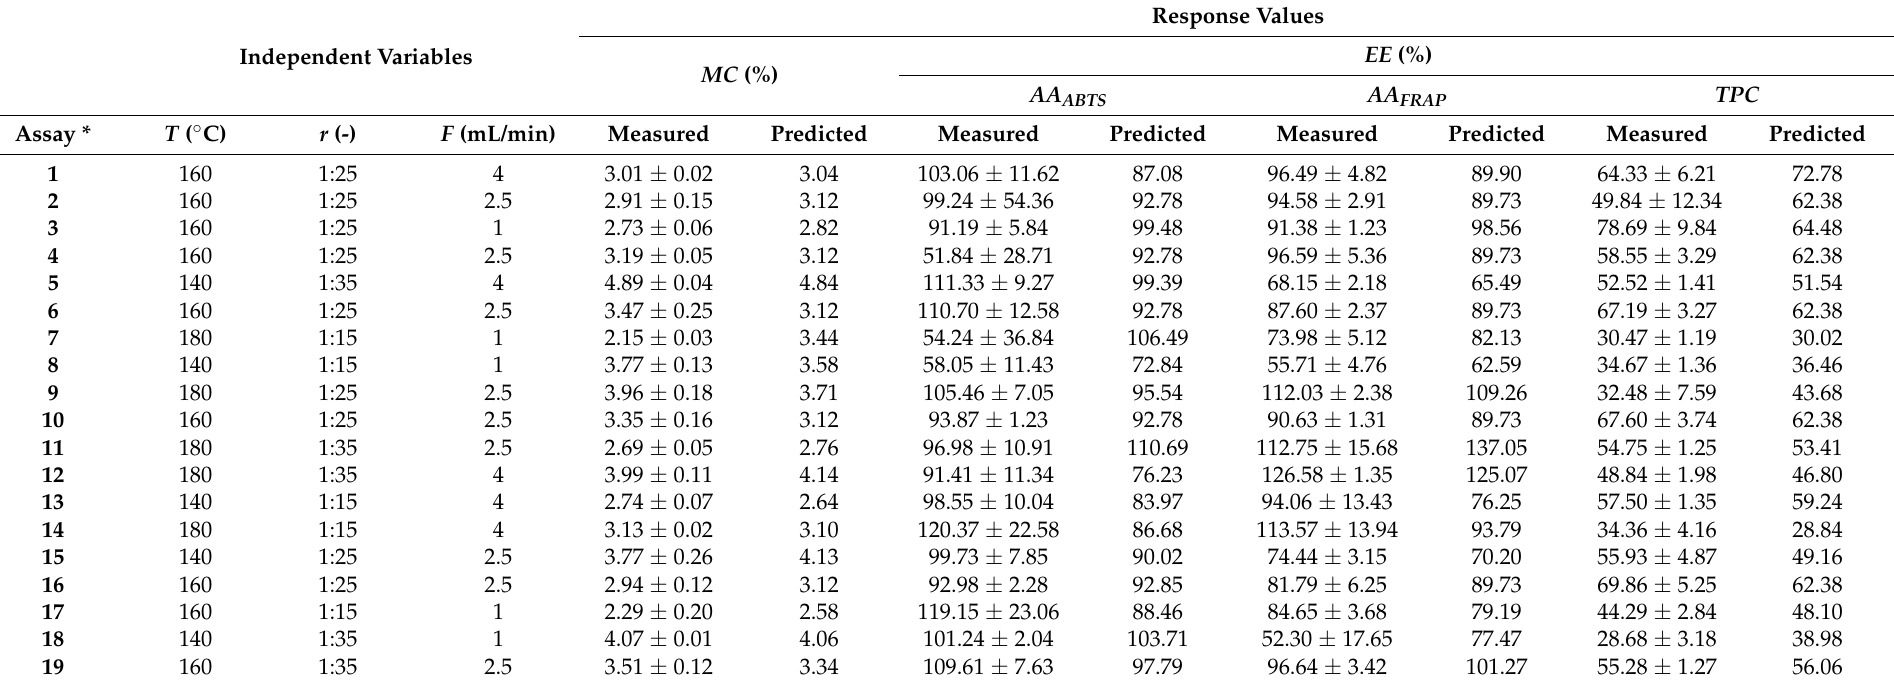
Table 1. Experimental design for the independent variables and corresponding response values (measured and predicted) for spray drying encapsulates from pine bark by-product